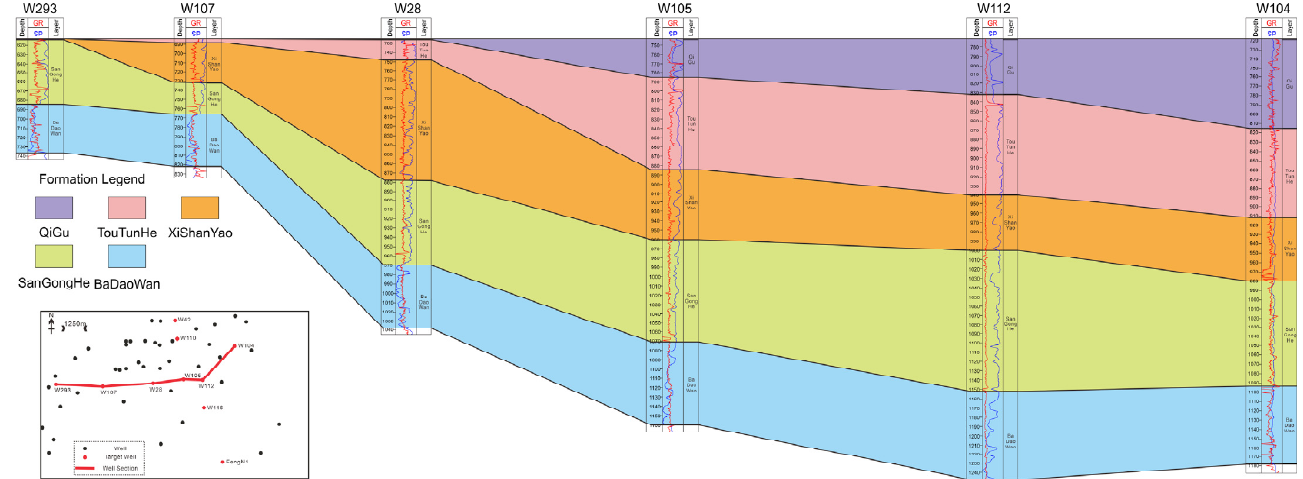
Figure 3. Stratigraphic correlation profile of the east–west section.